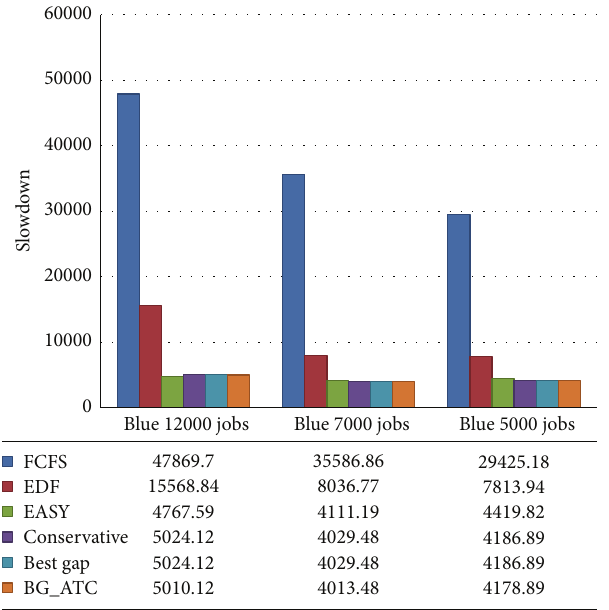
Figure 10: Slowdown comparisons on metacentrum workload.